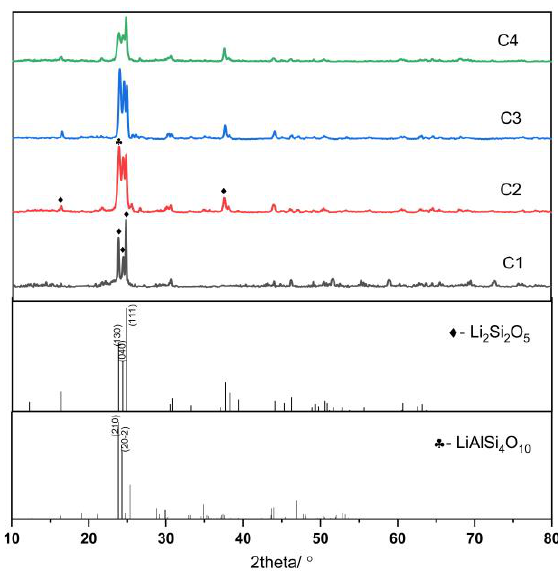
Figure 4. XRD pattern of lithium aluminosilicate